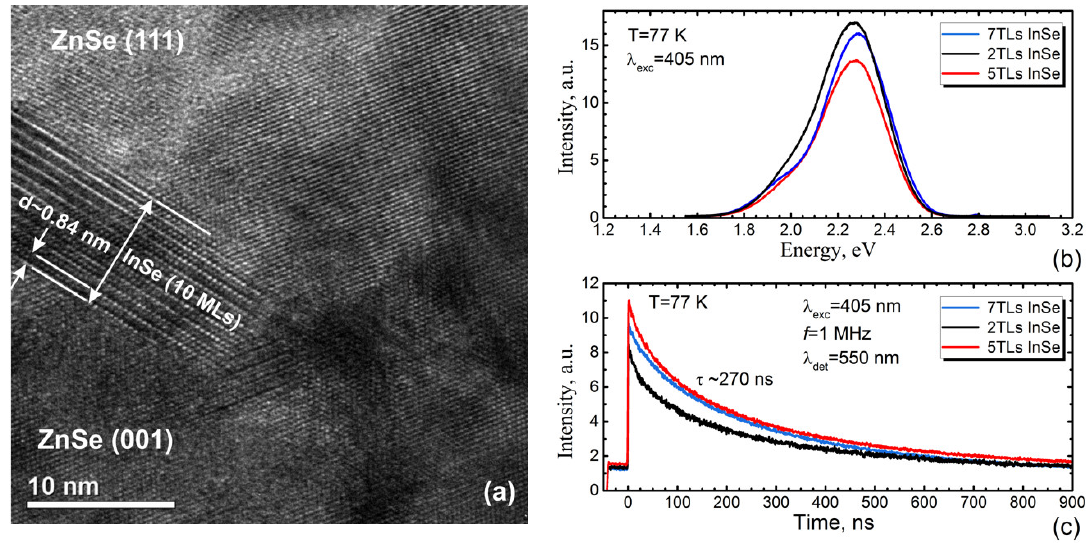
Figure 14. ( a ) Cross-section HRTEM image of the ZnSe/InSe/ZnSe QW structure with the InSe nominal thickness of ~7 TLs; ( b ) PL spectra of ZnSe/InSe/ZnSe QW structures with different InSe nominal thickness; ( c ) time-resolved measurements of the luminescence in ZnSe/InSe/ZnSe QW structures at T = 77 K. The samples were excited by 405 nm radiation of the CUBE laser (Coherent) with pulses of 45 ps duration at a repetition rate of 1 MHz.